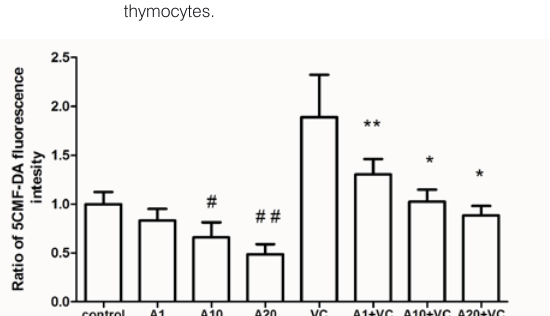
Table 1. In vitro effect of amiodarone and vitamin C on rat thymocyte